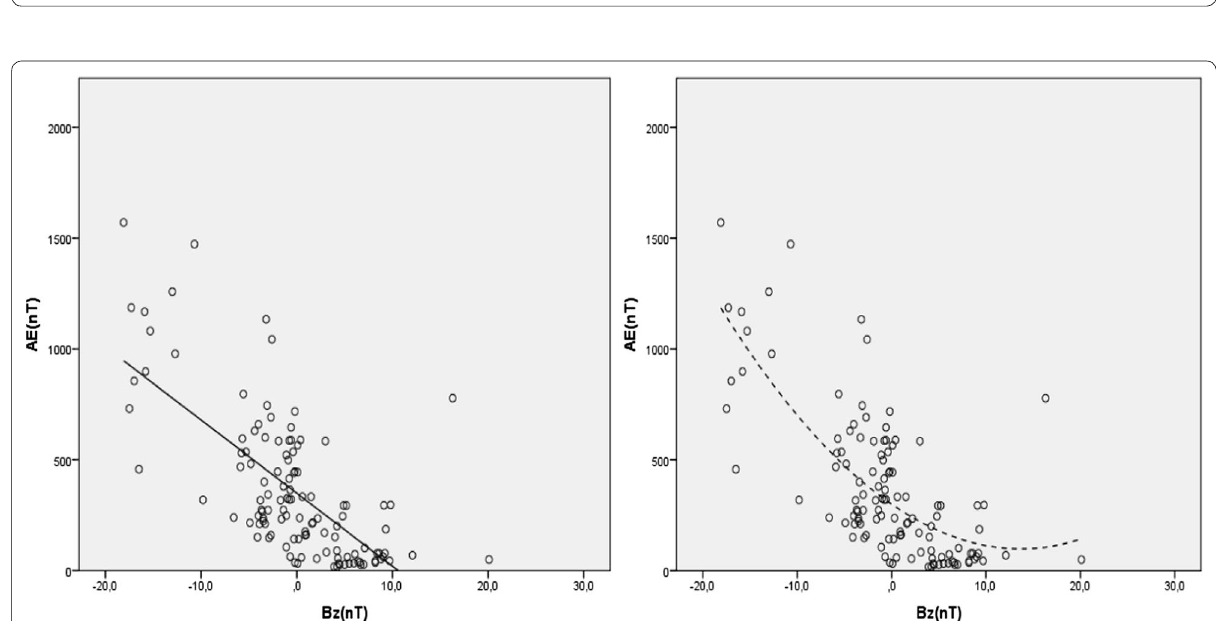
Fig. 4 Linear and quadratic relation between ap and B z . In figure, the nonlinear relationship between the magnetic field component B z and the ap index can be seen